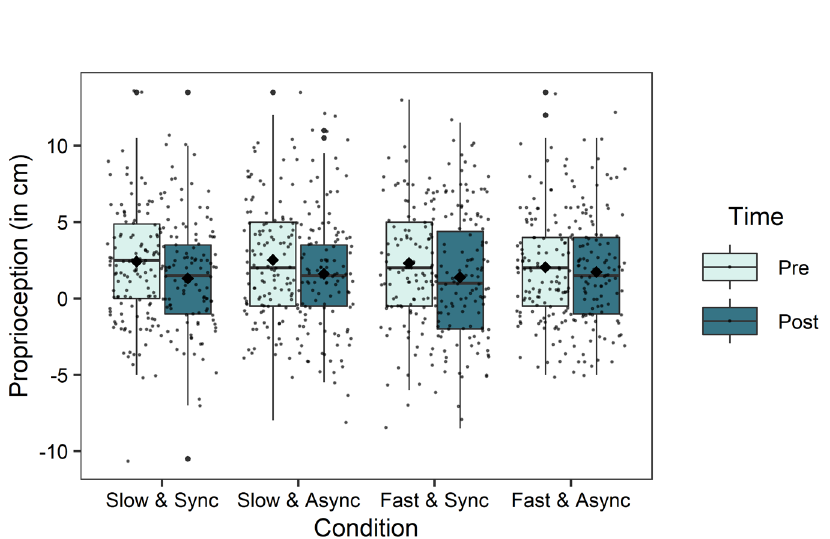
Figure 2. Visualization of the change in proprioception from pre to post stimulation in each condition, averaged across all groups. The rubber hand is positioned at −17.5 cm, accordingly, negative values indicate an estimated position between rubber hand and real hand. The means are indicated by the diamond shaped dots. The horizontal line represents the median. Sync Synchronous; Async